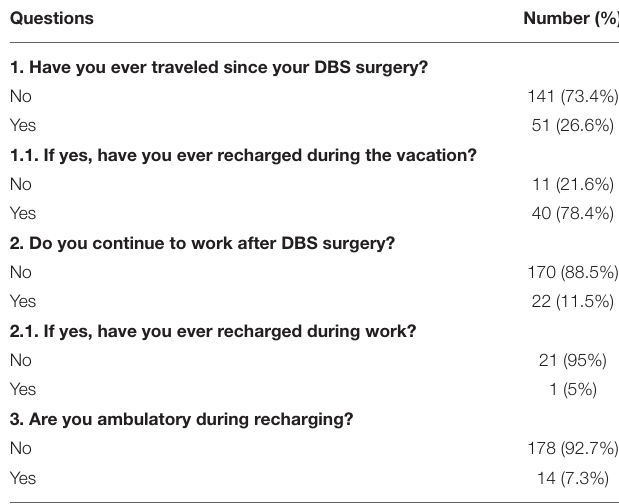
TABLE 3 | Patients’ experiences with battery recharging procedure ( N = 192). TABLE 4 | Mobility in patients living with a rechargeable IPG ( N =